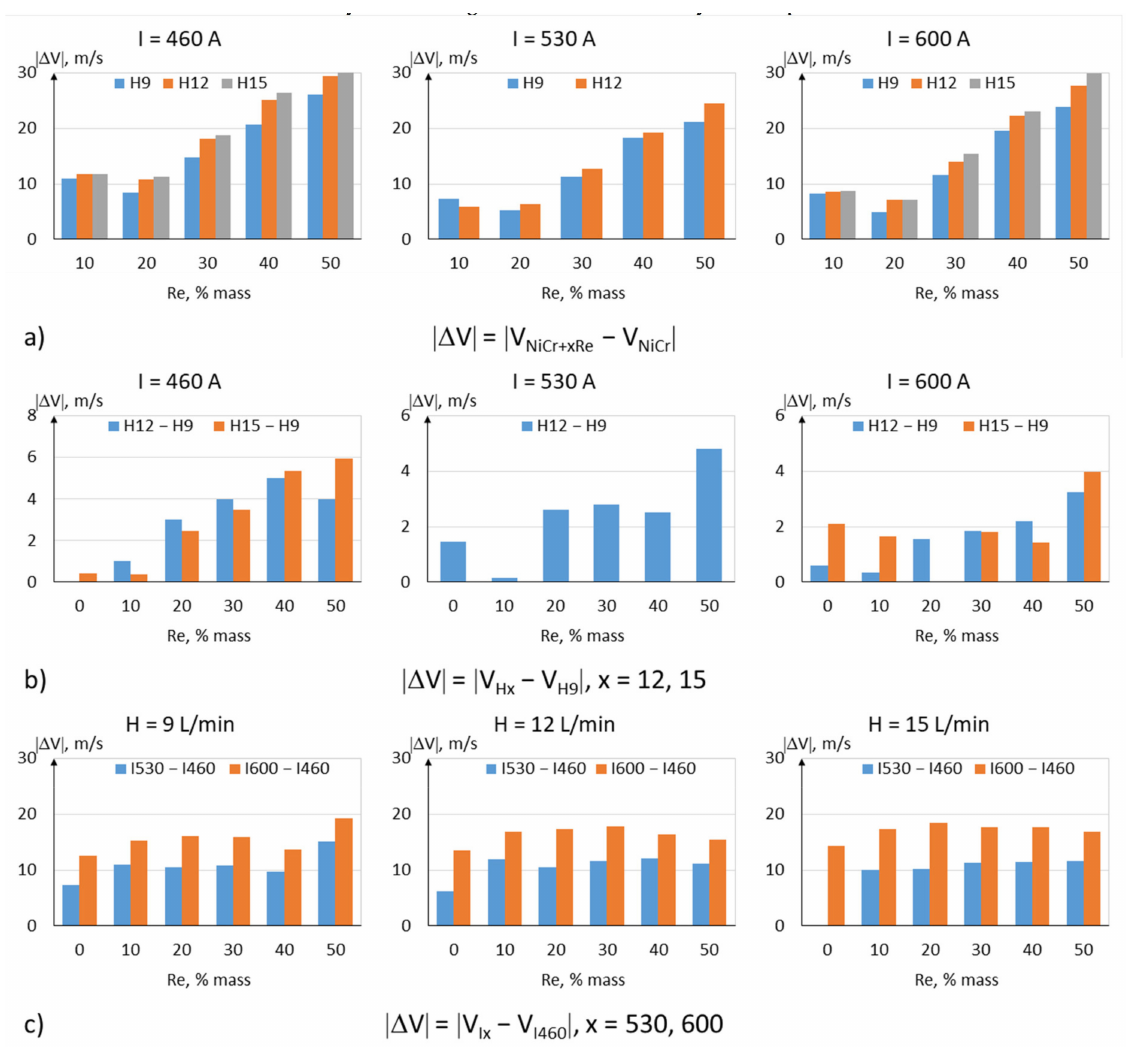
Figure 15. Changes in in-flight particle velocity | ∆ V|: ( a ) in relation to rhenium content, ( b ) in relation to hydrogen flowrate, and ( c ) in relation to current